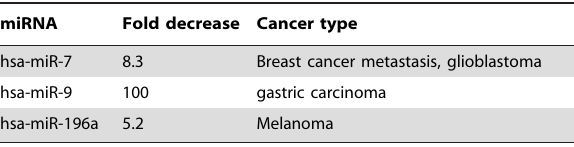
Table 2. miRNA decreased with AR expression and growth-promoting effect in cancers with increased expression (p , 0.05).